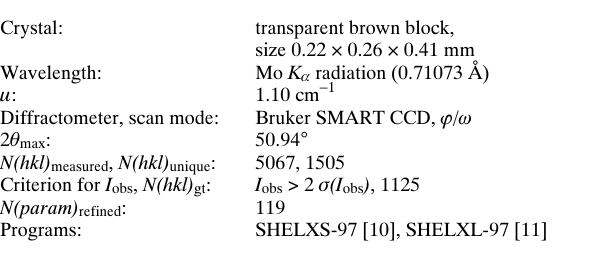
Table 1. Data collection and handling.